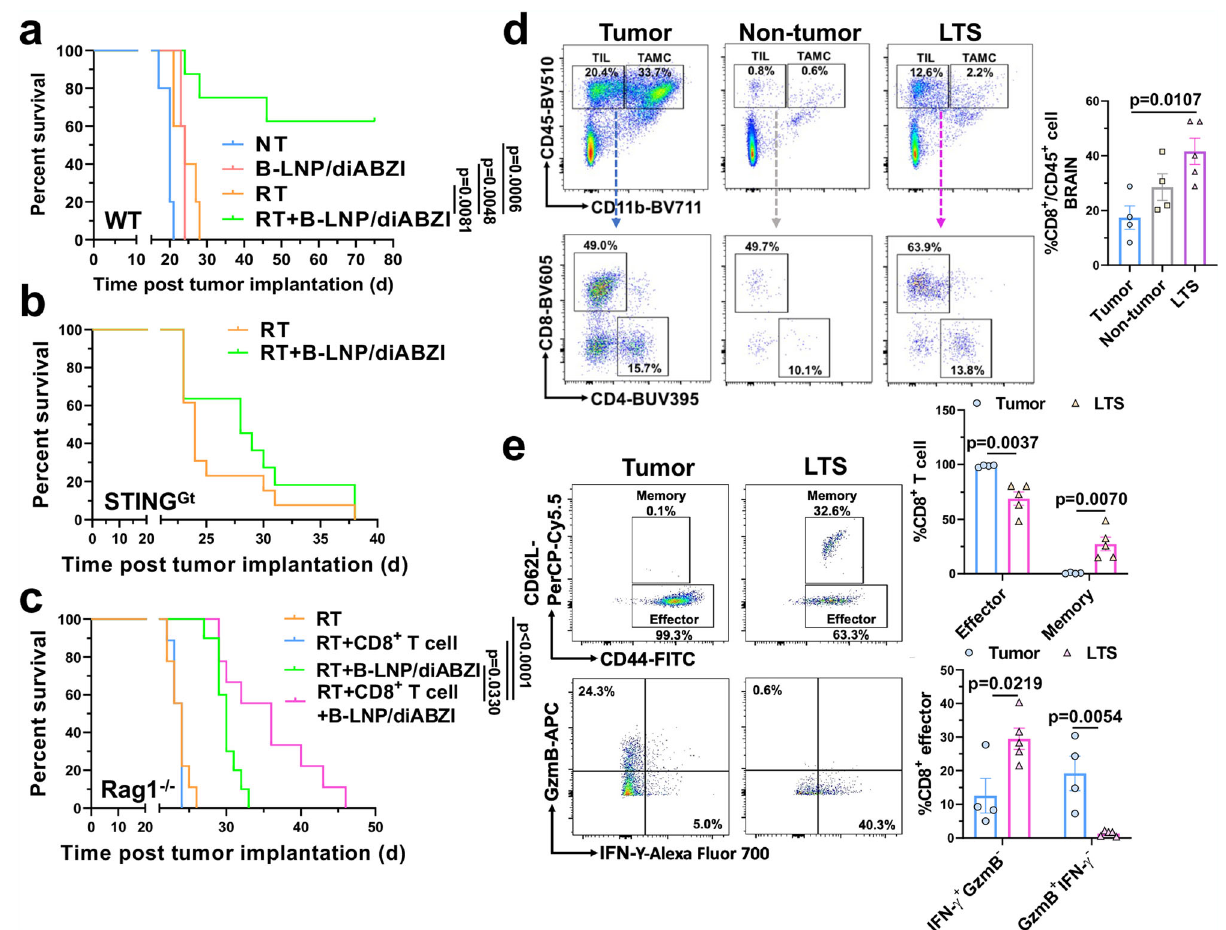
Fig. 8 | B-LNP/diABZI treatment potentiates the antitumor effects of radio- therapy in glioma-bearing mice. a – c Survival curves of C57 wildtype (WT) ( a ), STING Gt ( b ), and Rag1 -/- ( c ) mice received intracranial implantation of 5×10 4 CT-2A gliomacellsandtwoadministrationsofsalineorB-LNP/diABZI(0.25mg/kgdiABZI) through an intracranially implanted cannula. Selected groups of mice received radiotherapy (RT, 3Gy×3) as monotherapy or combination therapy starting from the seventh day post-tumor implantation. In ( c ) selected groups of mice